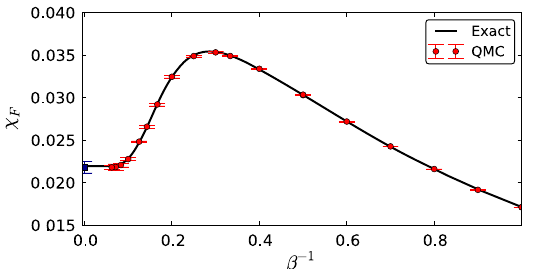
FIG. 8. QMC results for the fidelity susceptibility compared with exact results (solid line). The nonzero-temperature QMC data (red dots) are obtained from Eq. (9), while the ground-state data (blue square at β − 1 ¼ 0 ) are obtained from Eq. (11) in a projector LCT-INT calculation [89]. The system is the same as in Fig.